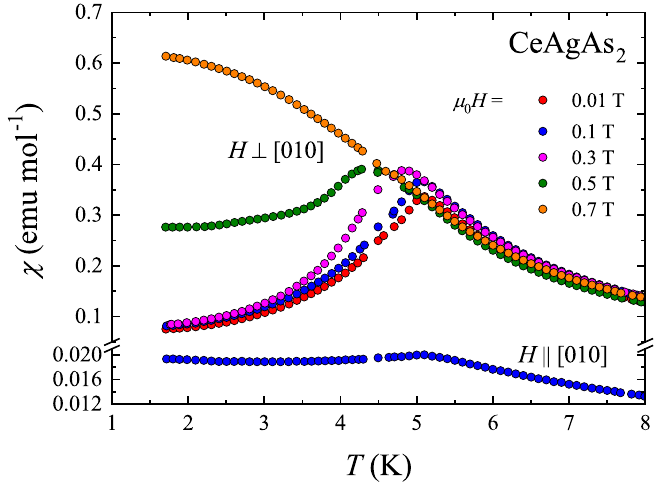
Figure 2. Temperature dependencies of the molar magnetic susceptibility of single crystalline CeAgAs 2 measured in a magnetic field of different magnitude oriented perpendicular to the crystallographic [010] axis and in a field of 0.1 T applied parallel to the [010]